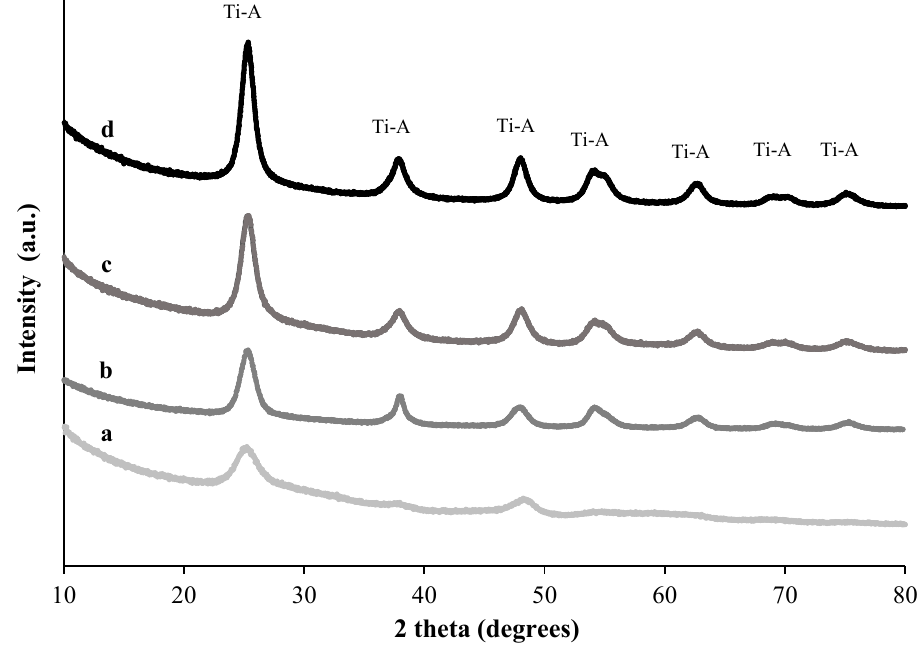
Figure 2. X-Ray Diffraction ( XRD ) patterns of titania-based materials prepared by microwave heating Figure 2. X-Ray Di ff raction (XRD) patterns of titania-based materials prepared by microwave heating with different programs of heating ( a ) 320 W 3 min ramp then 10 min at 150 °C, ( b ) 320 W 3 min ramp with di ff erent programs of heating ( a ) 320 W 3 min ramp then 10 min at 150 ◦ C, ( b ) 320 W 3 min ramp then 30 min at 150 °C, ( c ) 320 W 3 min ramp then 45 min at 150 °C, and ( d ) 600 W 2 min ramp then 10 then 30 min at 150 ◦ C, ( c ) 320 W 3 min ramp then 45 min at 150 ◦ C, and ( d ) 600 W 2 min ramp then min at 150 °C. 10 min at 150 ◦